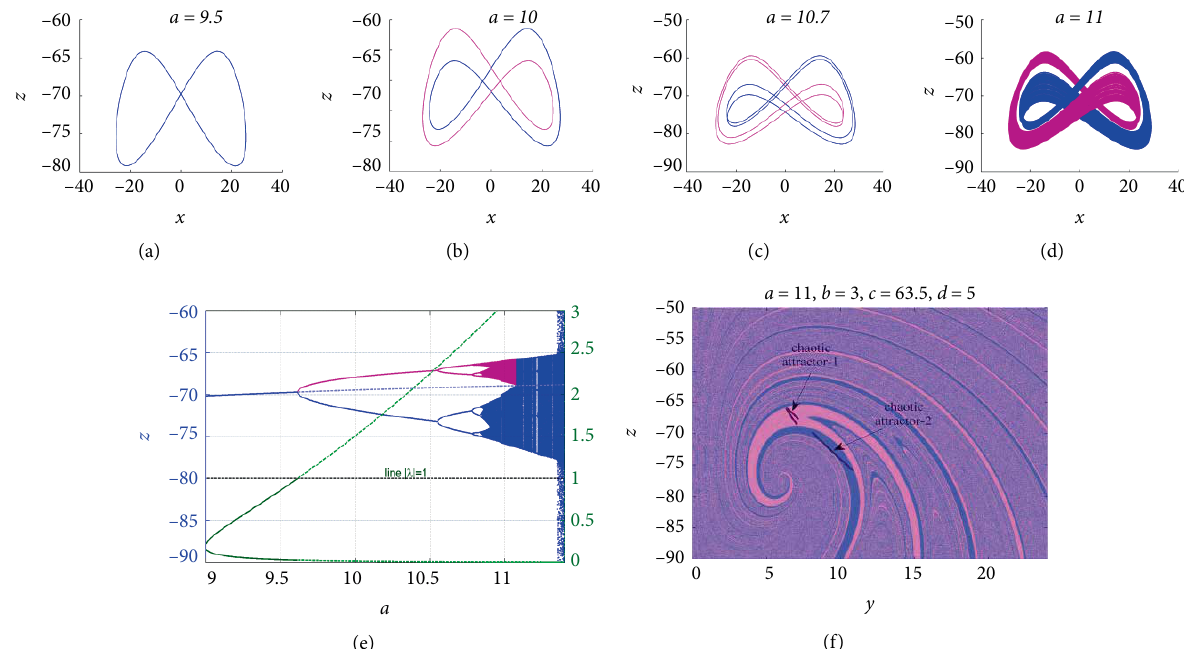
Figure 4: The detailed dynamics and bifurcations of the main